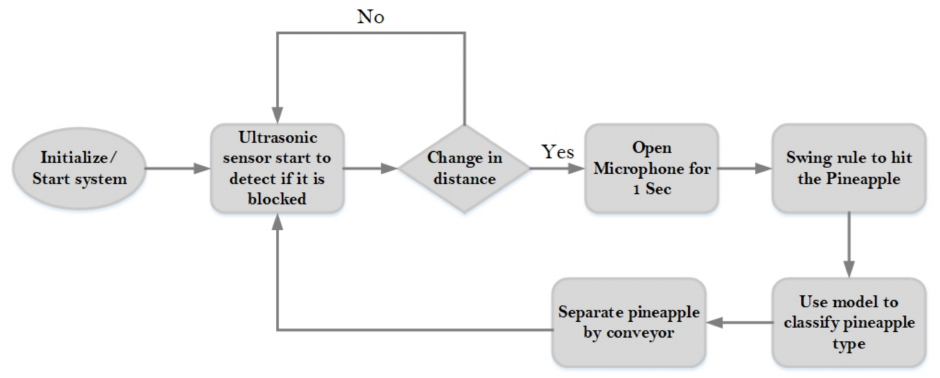
Figure 5. Flowchart of the proposed automatic classification system.